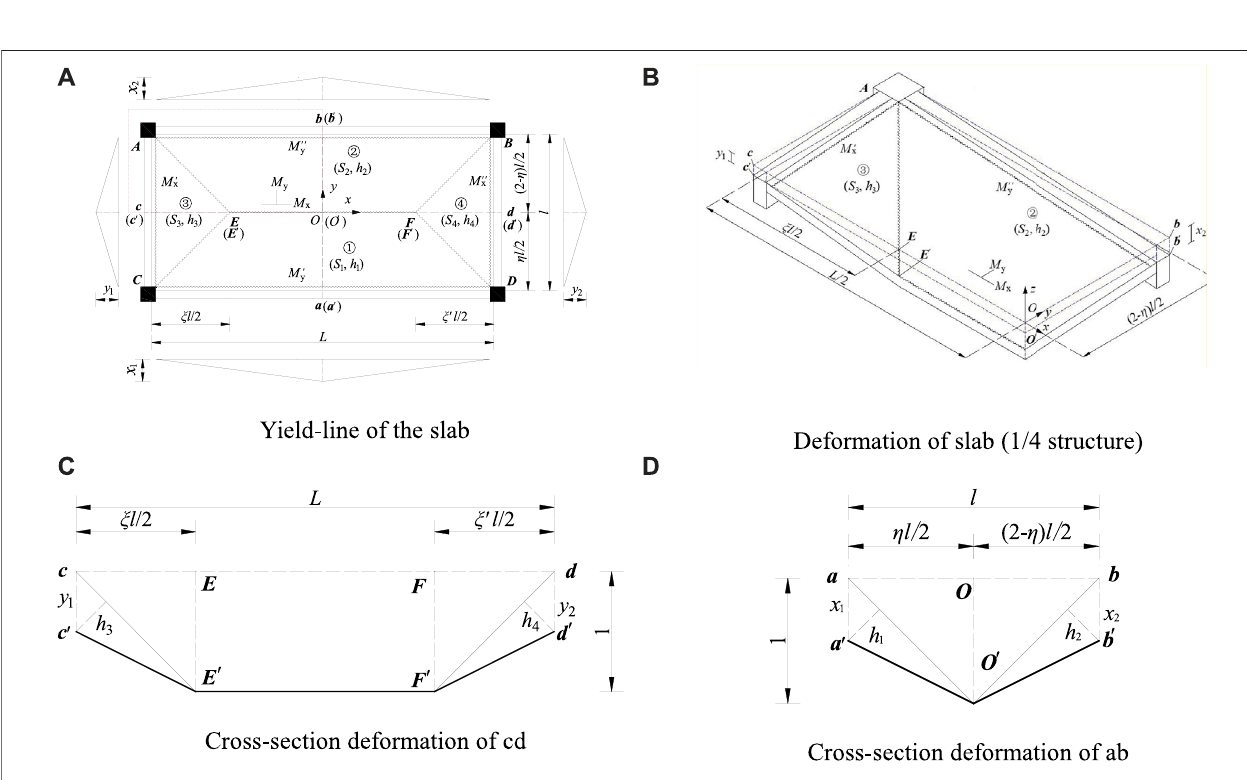
Frontiers in Built Environment |